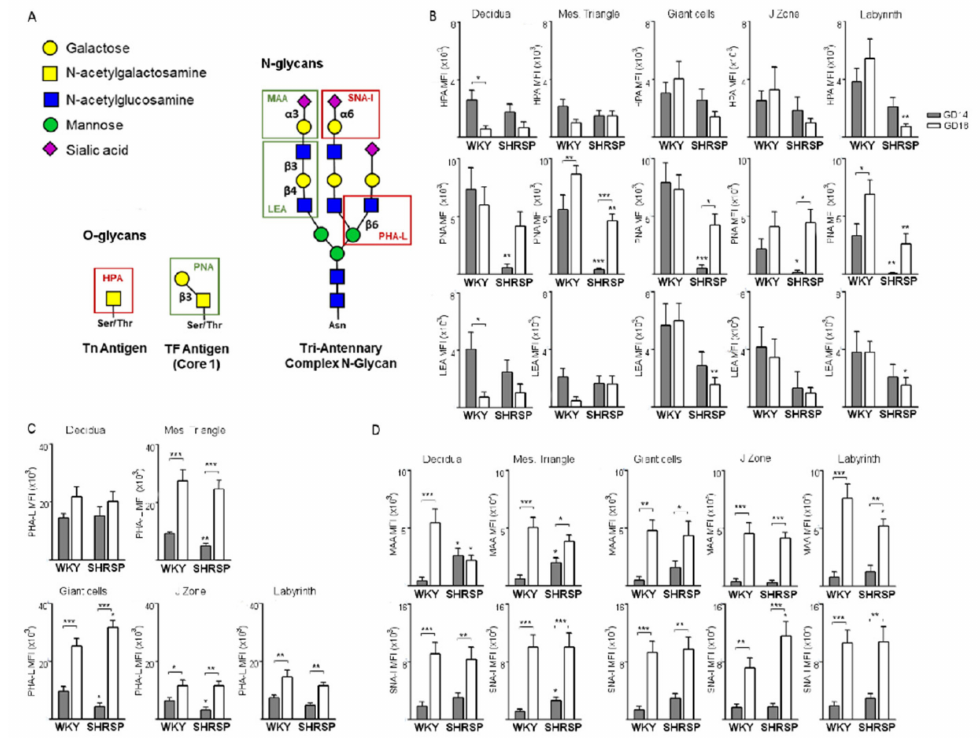
Figure 4. Lectin-based profiling of the placental glycophenotype associated with SPE progression. ( A ) Schematic representation of the O - and N -glycan moieties recognized by the lectin panels used in the present study. ( B ) Placental expression levels of O- (HPA and PNA lectins, upper and middle panels, respectively) and polyLacNAc-extended glycans (LEA, bottom panels) in both models. Results are expressed as mean fluorescence intensity (MFI). ( C ) Analysis of the expression of complex branched N -glycans in the different placental layers as assessed by PHA-L binding. ( D ) Levels of terminal α 2,3- (MAA, top panel) and α 2,6-sialylation (SNA-I, bottom panel) in both pregnancy models. The results are presented as the means ± SEM, n = 5–7 animals/group. In all the panels, * p < 0.05, ** p < 0.01 and *** p < 0.001 as evaluated by two-way ANOVA and Bonferroni post-hoc